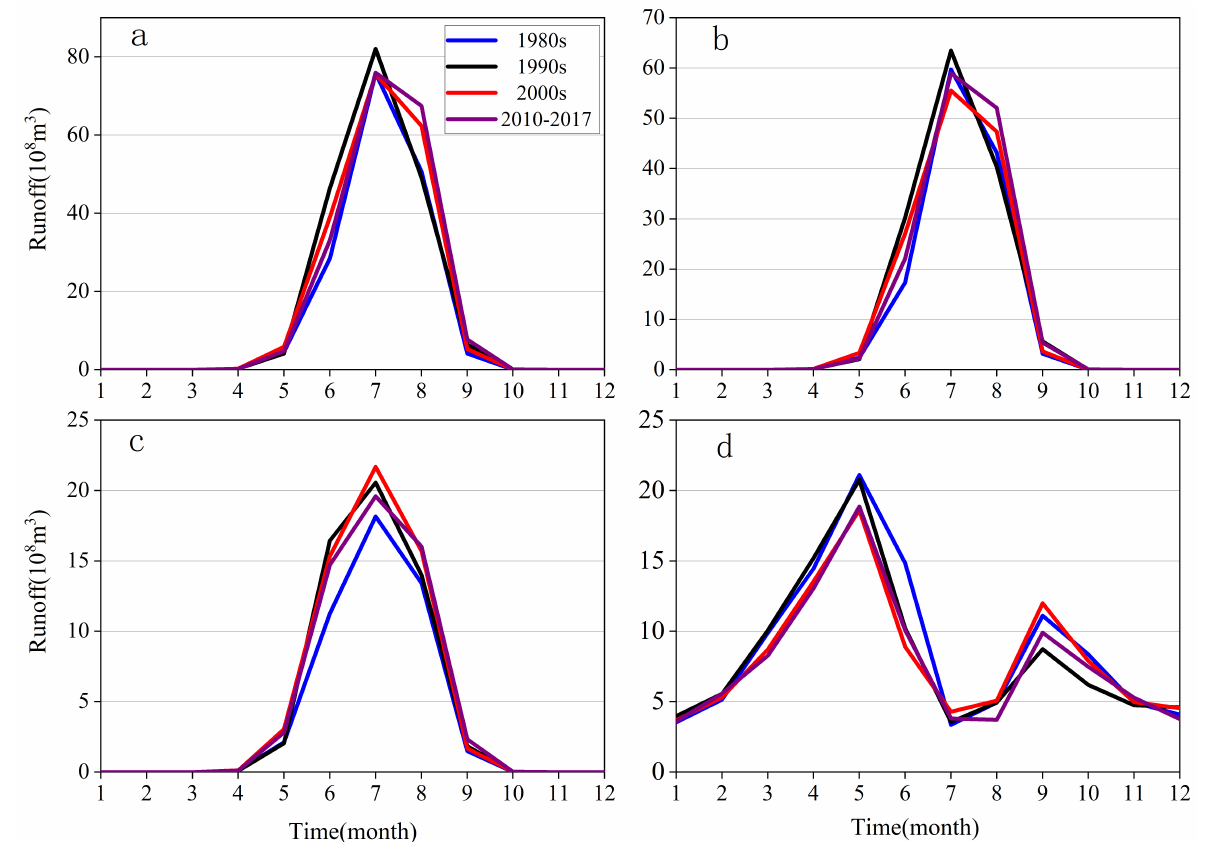
Figure 7. Intra-annual and interdecadal variations in glacier runoff ( a ) and its components (( b ) glacier meltwater, ( c ) glacier precipitation, and ( d ) snowpack) in the Tien Shan Mountains of Central Asia from 1980 to